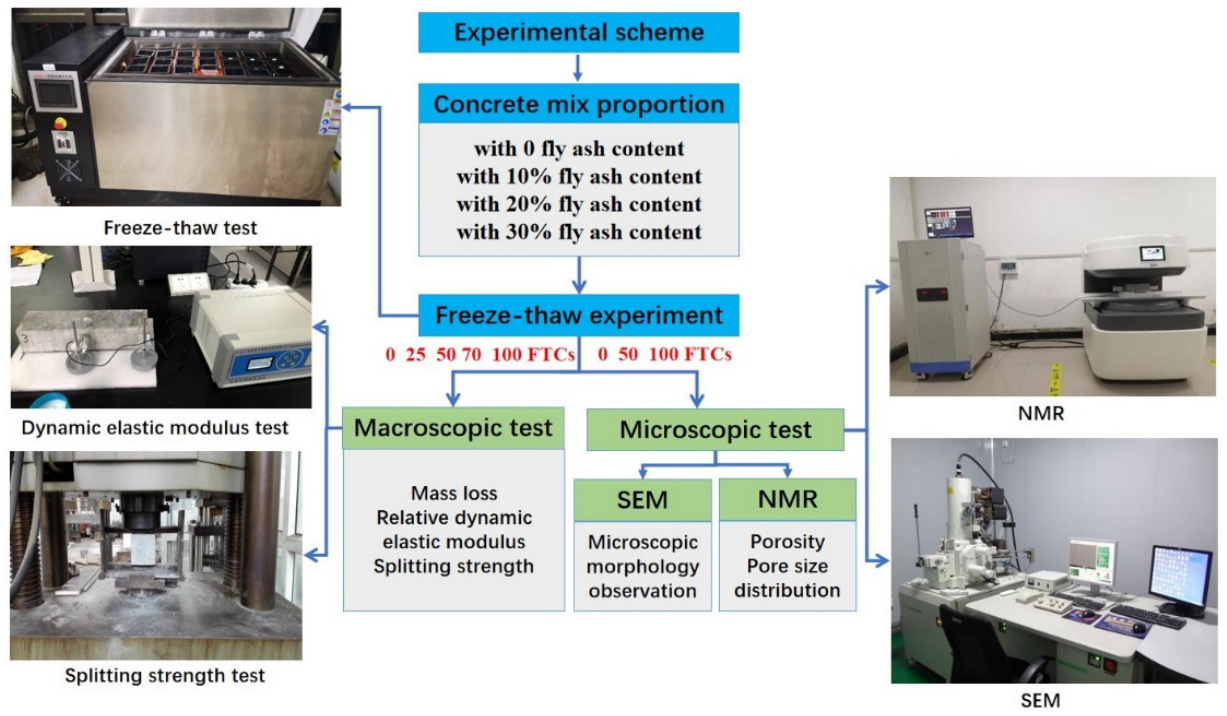
Figure 1. Flow diagram of the experiment.